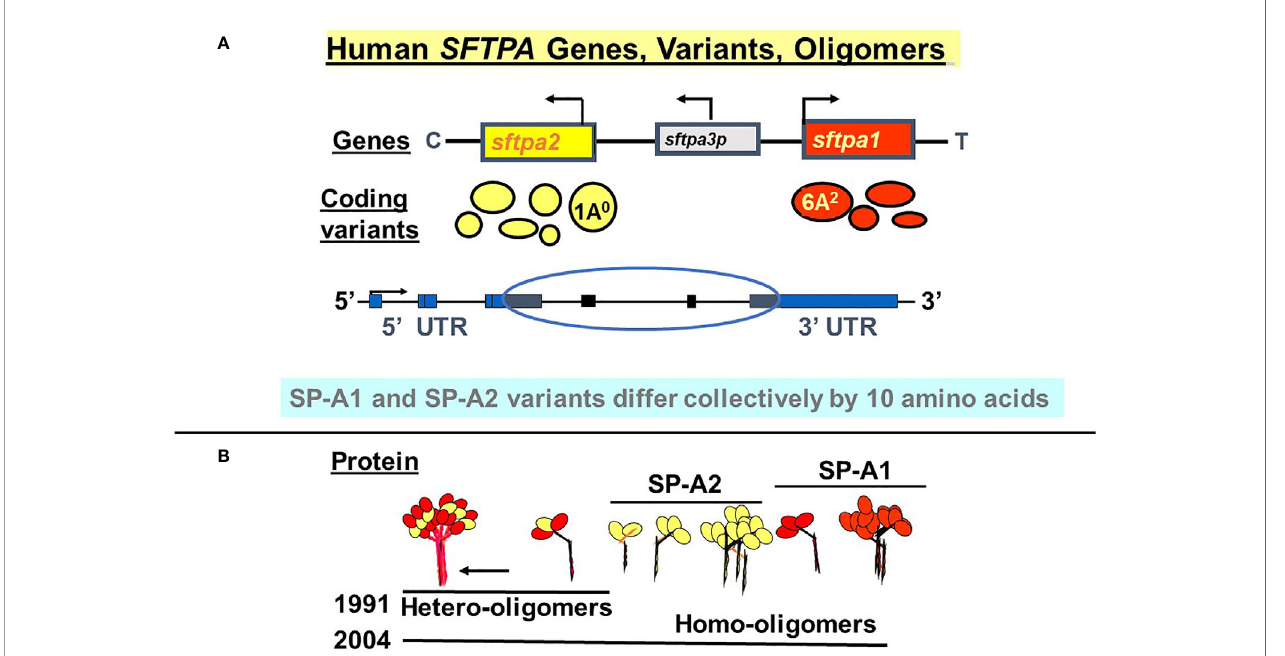
FIGURE 3 | Human SFTPA genes, variants, and oligomers. (A) depicts the chromosomal SFTPA genetic locus from the centromere (C) to telomere (T) as well as the opposite transcriptional orientation (arrow) of the two functional genes ( SFTPA1 and SFTPA2 ). The pseudogene ( SFTPA3P ) is between the two functional genes. The most frequently found coding variants are depicted below each gene. The size of the circle denotes the relative frequency with the 1A 0 and 6A 2 being the most frequently observed variants in the general population. A schematic of the gene organization is shown, depicting the 5 ’ and 3 ’ UTR (blue boxes) and the coding regions (black boxes, circled). (B) depicts hetero-oligomers of SP-A1 and SP-A2 described in 1991 (38) and homo-oligomers described in 2004